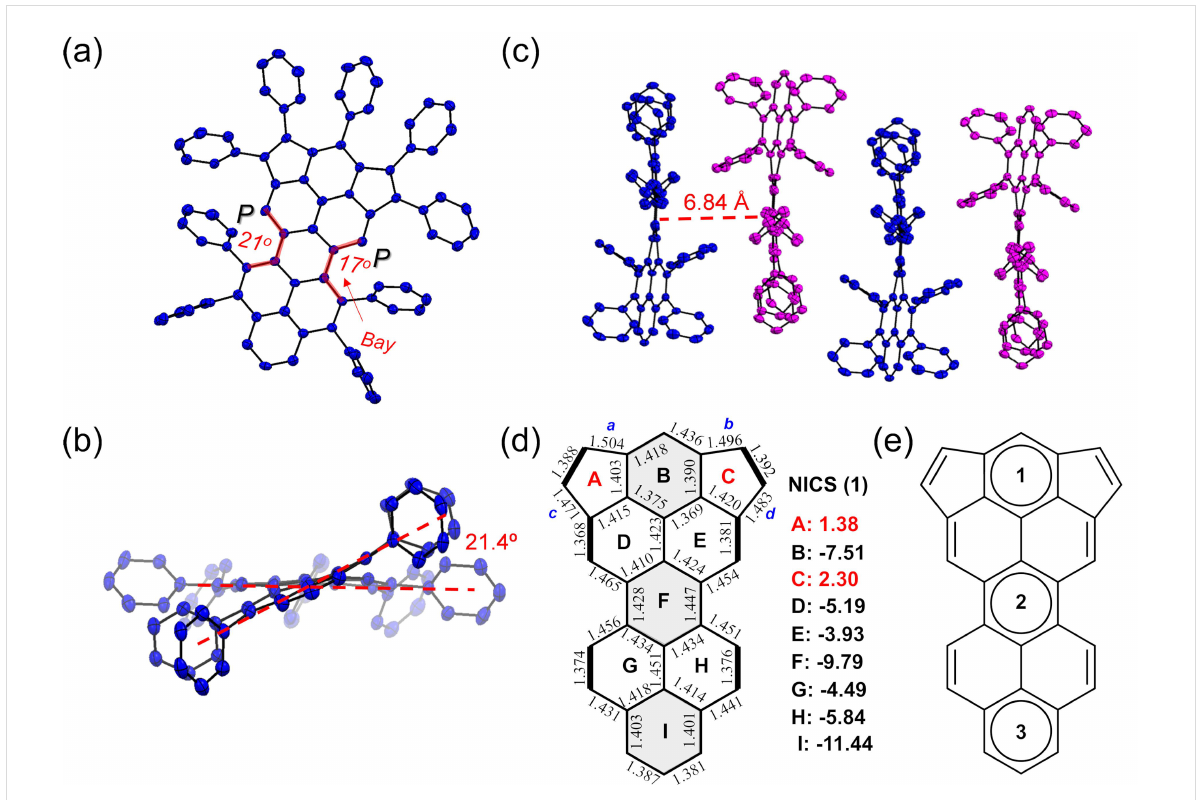
Figure 2: Single-crystal X-ray structure of 1 . (a) Top view and (b) side view of the ( P , P ) isomer. c) Crystal packing of the enantiomer pairs ( P , P and M , M ) of 1 . Hydrogen atoms and solvent molecules are omitted for clarity. (d) Selected bond lengths (from the crystal structure) and calculated NICS(1) values of rings A–I in 1 . (e) Clar valence structure representation of 1 with three benzeneoid rings.